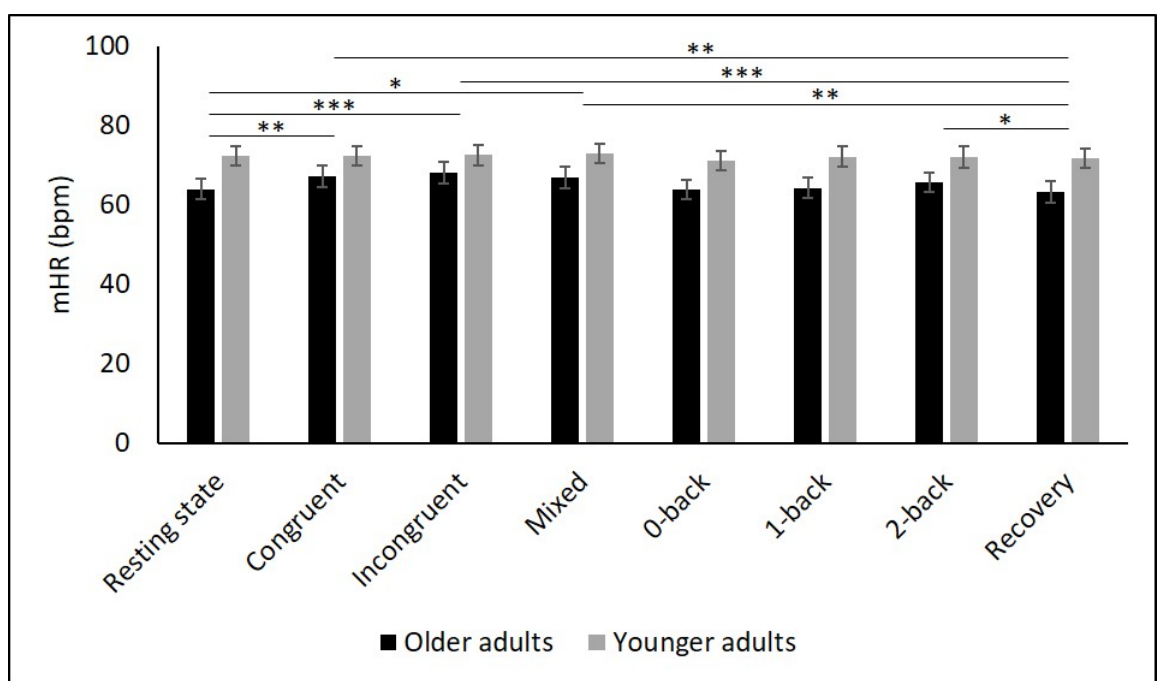
Figure 2. Means and group × condition interactions for mHR. Error bars indicate ± 2 standard error of mean; abbreviations: